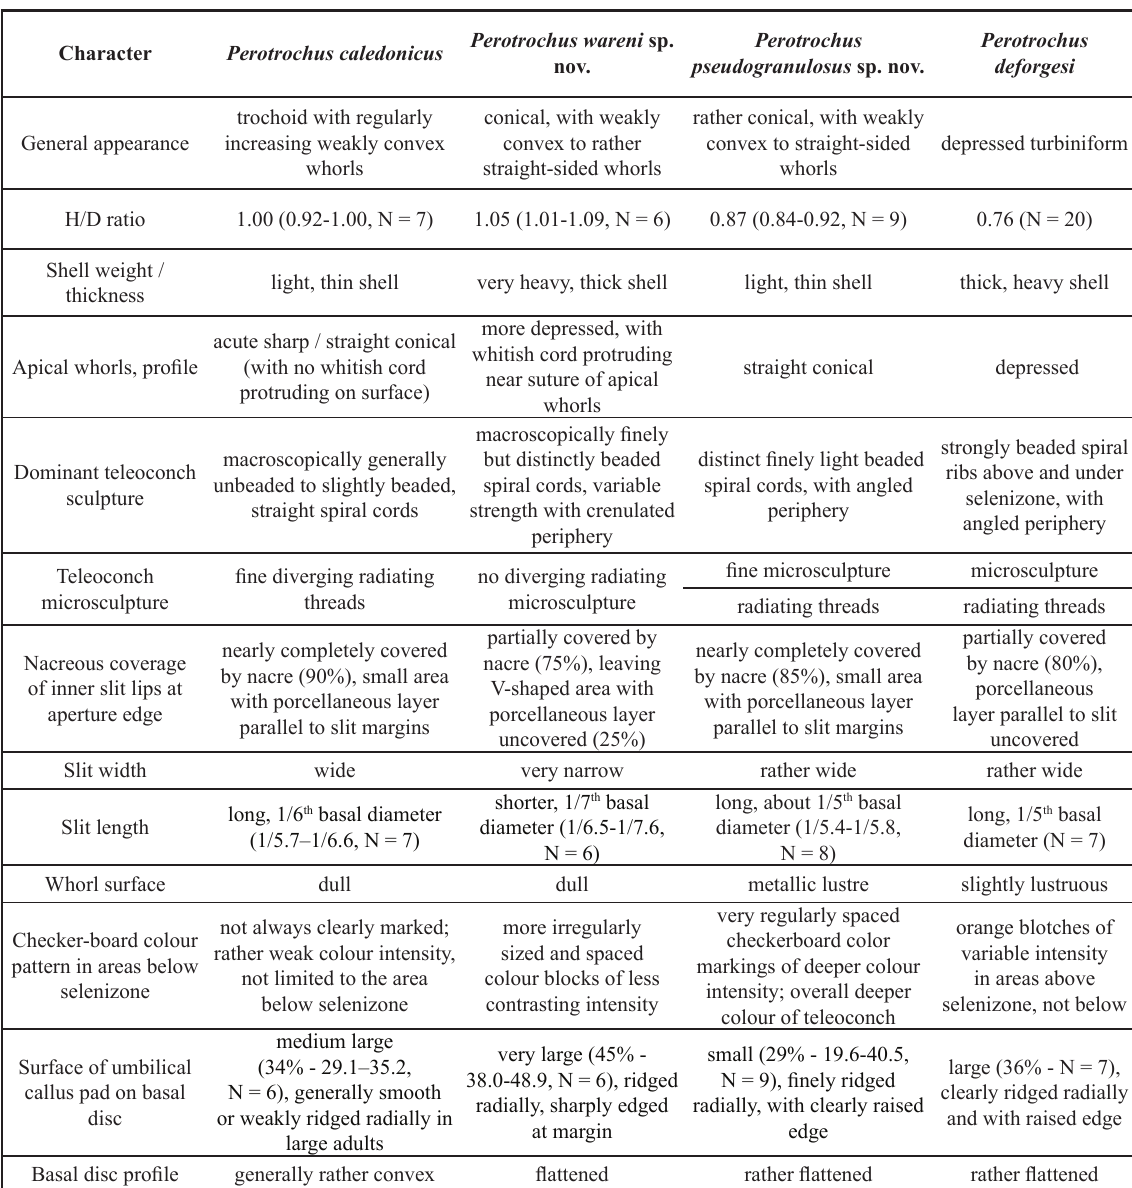
Table 2. shell characters in the Perotrochus caledonicus species complex. Measurements correspond to mean values (with ranges) calculated on n specimens. Values for P. deforgesi are taken from Métivier